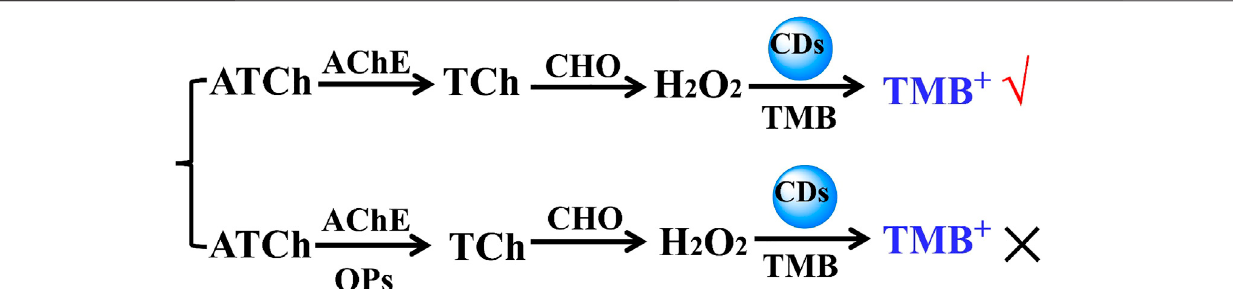
FIGURE 10 | Schematic illustration of detection of OPs based on the photochemical sensing system of the suppressive AChE activity.